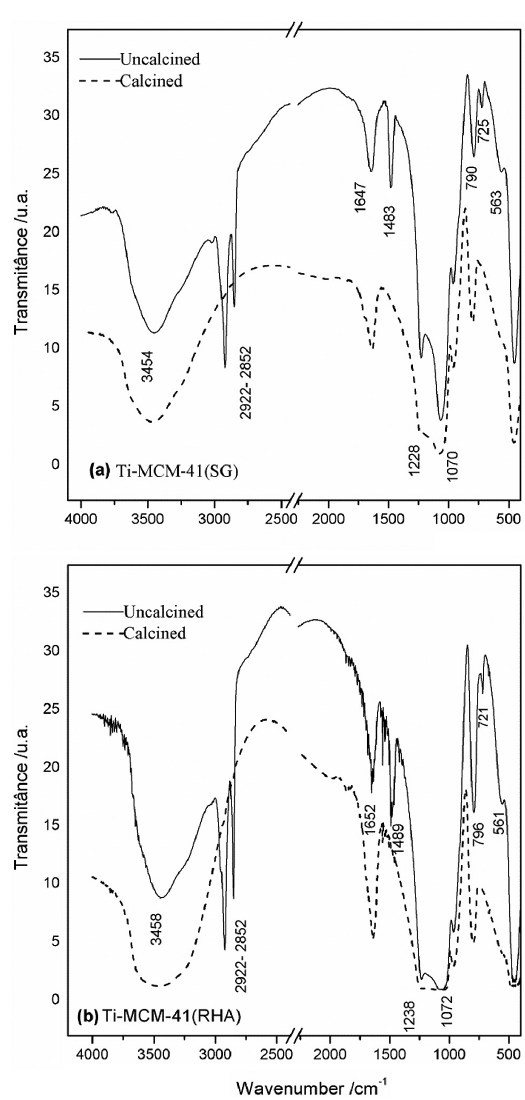
Figure 5. FTIR spectra of calcined and uncalcined of TiMCM- 41(SG) and Ti-MCM-41 (RHA).